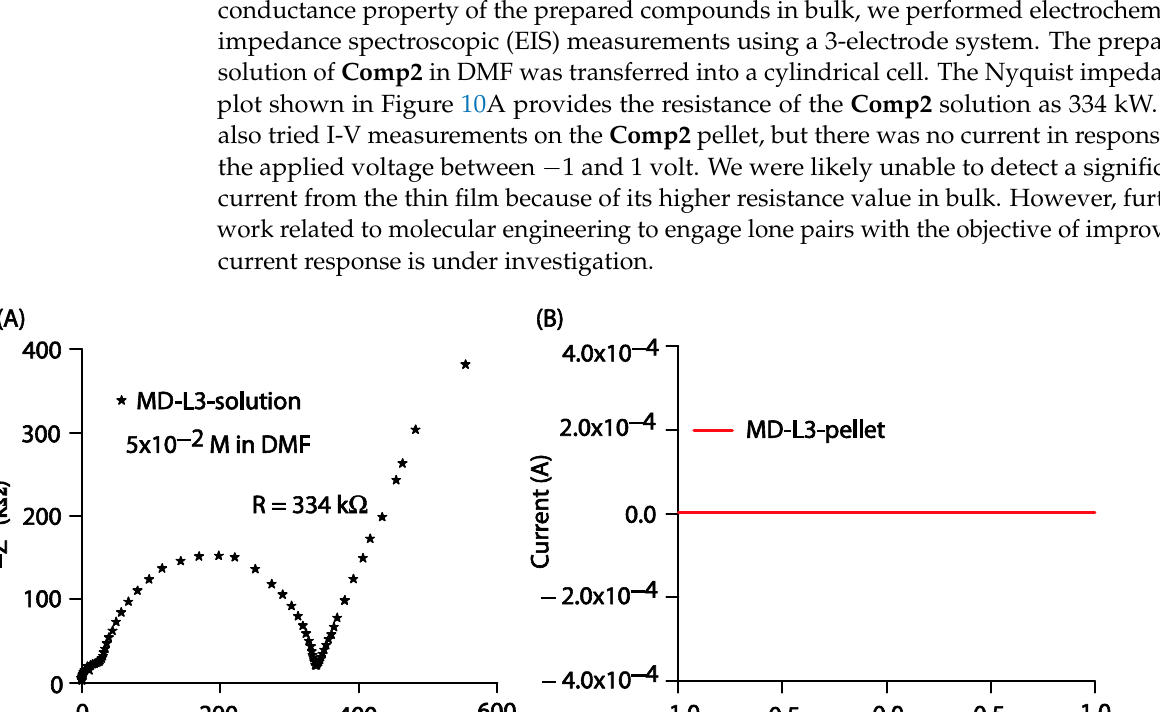
Figure 9. UV–vis spectrum of ( A ) Comp3 (0.5 × 10 −5 M) in DMF and DMSO; ( B ) Comp4 (0.5 × 10 −5 M) in acetone, ethanol, DMF, and DMSO.